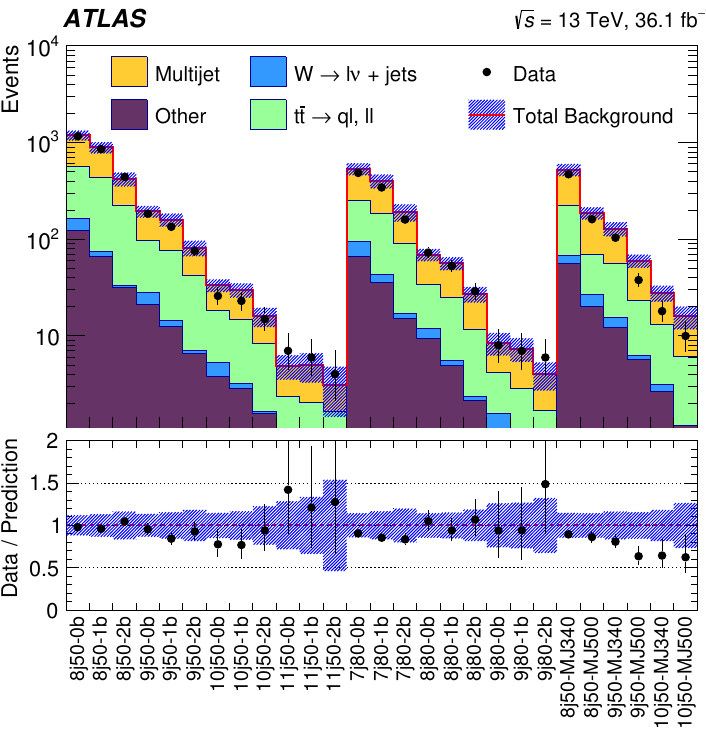
Figure 4. Summary plot showing the data and SM predictions constrained by the likelihood (cid:12)t for all signal regions. Systematic and statistical uncertainties are shown in the blue hatched band, accounting for (anti-)correlations in their e(cid:11)ects on di(cid:11)erent background components. The lower panels show the ratio of the observed data to the total SM background.